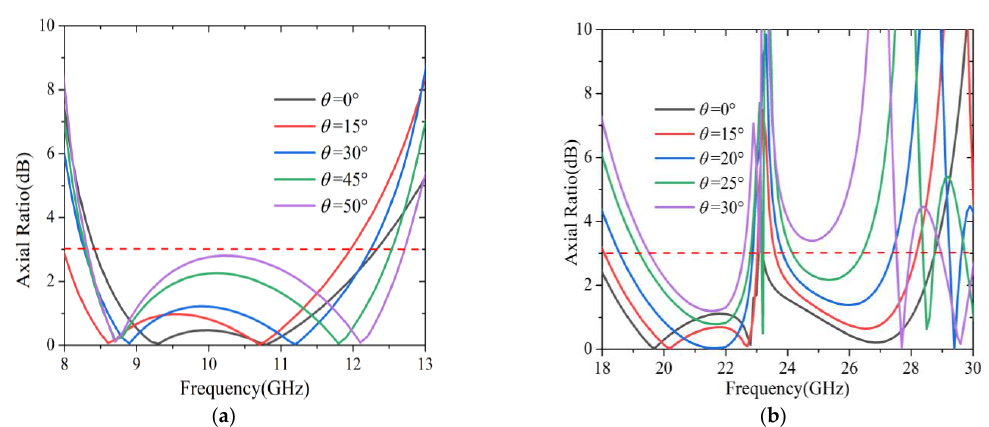
Figure 9. The axis ratio under different oblique incidence for: ( a ) The lower band; ( b ) The higher band.